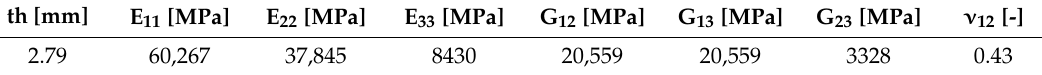
Table 6. Equivalent laminate mechanical properties.